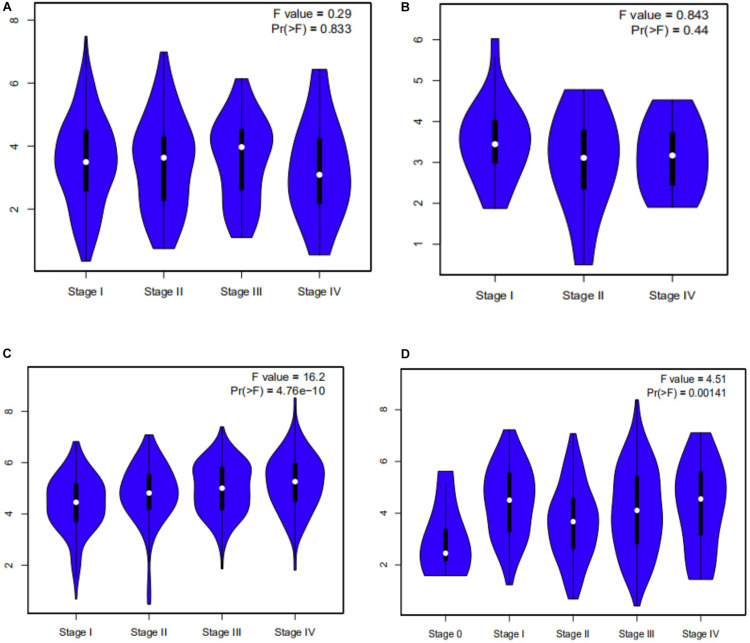
Violin plots pf FCGR1A expression in different stages of four cancers. (A) CESC, (B) CHOL, (C) KIRC, and (D) SKCM.